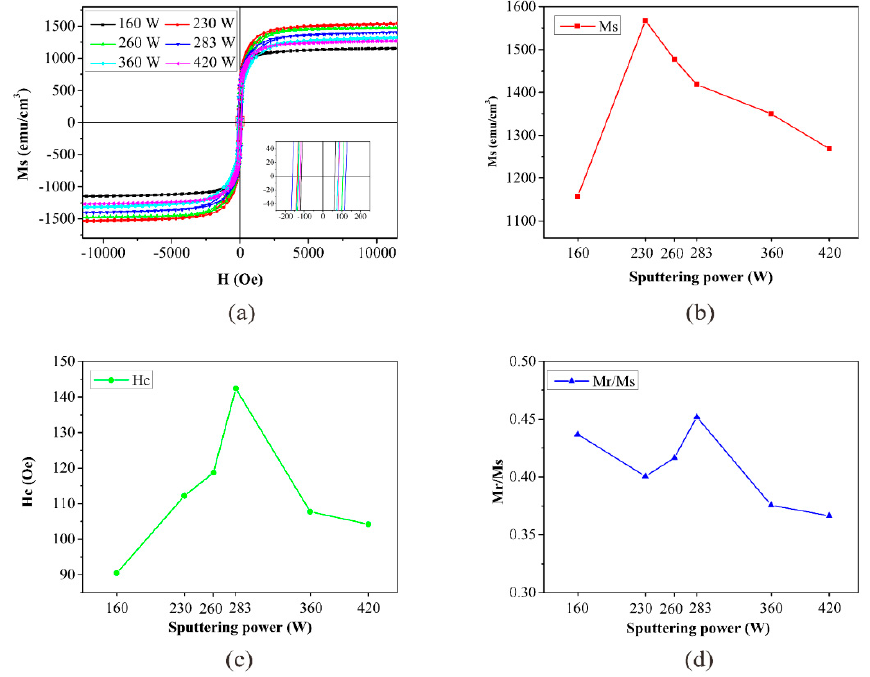
Table 1. Magnetic properties of iron thin films under different preparation conditions.